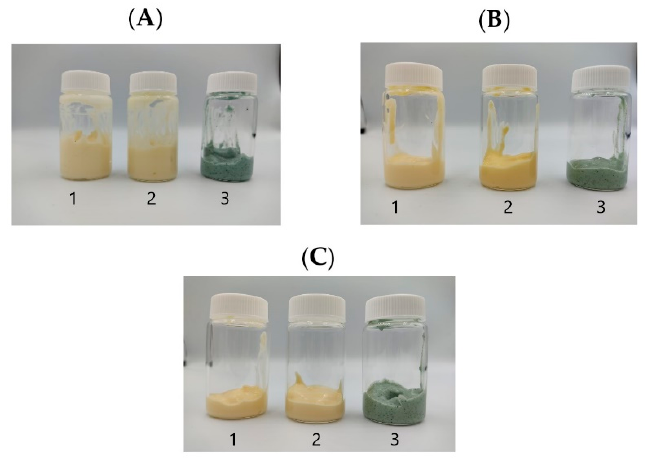
Figure 7. Low-fat mayonnaises obtained with 30%, 22.5%, and 15% oil (panels ( A ), ( B ), and ( C ), respectively). 1 = A, B, and C samples. 2 = D, E, and F samples. 3 = D’, E’, and F’ samples.